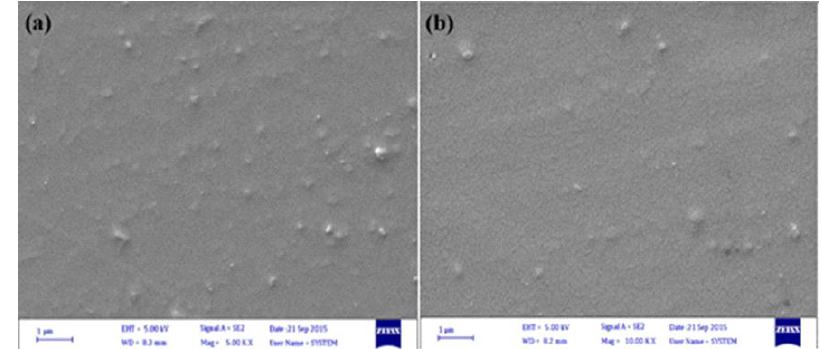
Fig. 2. SEM images surface of (a) A7 and (b) A8 samples.